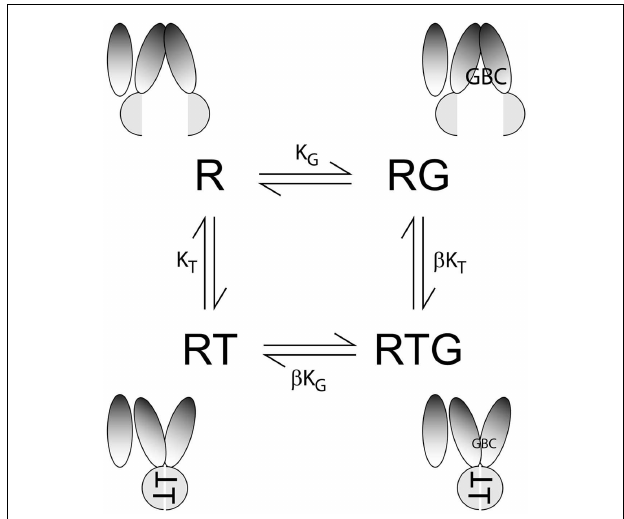
FIGURE 1 | Four-state equilibrium model . R, RG, RT, and RTG represent the unliganded receptor, R, and receptors with GBC (G), ATP (T), or GBC + ATP bound, respectively. K G and K T are equilibrium dissociation constants, for GBC and ATP, respectively; β is an allosteric constant; values of β > 0 reflect a reduced affinity of nucleotide-bound SUR for [ 3 H]GBC. At given values of K G and K T , β specifies the plateau value at a saturating concentration of nucleotide.The cartoons represent the conformations of the four states based on homology models of SUR1 closed and open states derived from crystal structures of evolutionarily related bacterial ABC exporters in the presence (31, 32) and absence of nucleotides (33, 34),